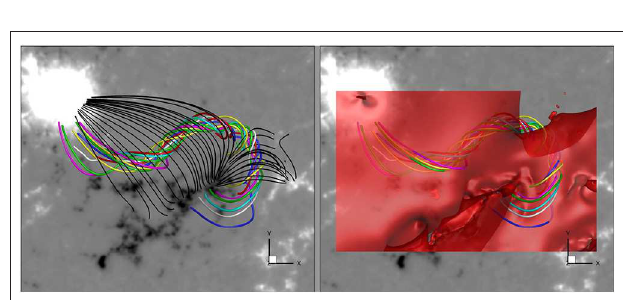
FIGURE 5 | Left : the color lines represent the MFR, while the black lines show sampled field lines of the strapping field overlying the MFR. These field lines are plotted using the potential field model extrapolated from the vertical component of the magnetogram. Right : the red, transparent surface is the iso-surface with magnetic decay index n = 0.5, and as can be seen, the significant part of the MFR is below the